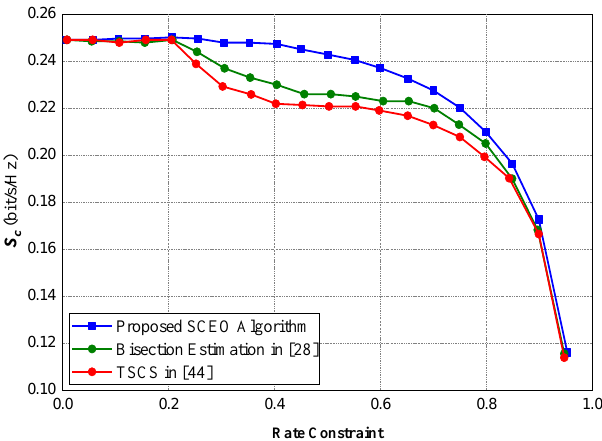
Figure 10. Performance of the algorithms with different rate constraints for p = 20 dB.